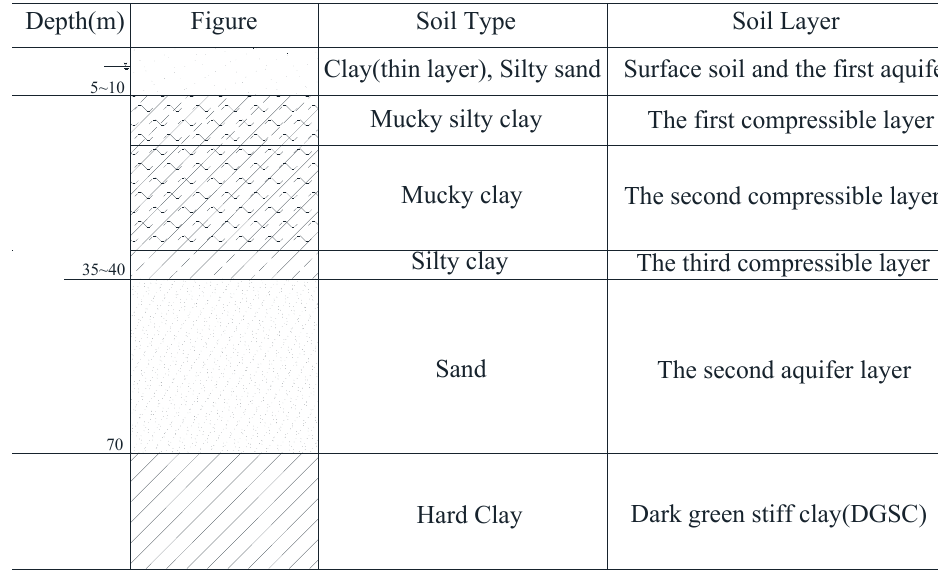
Figure 2. Shanghai geology and hydrology profile.